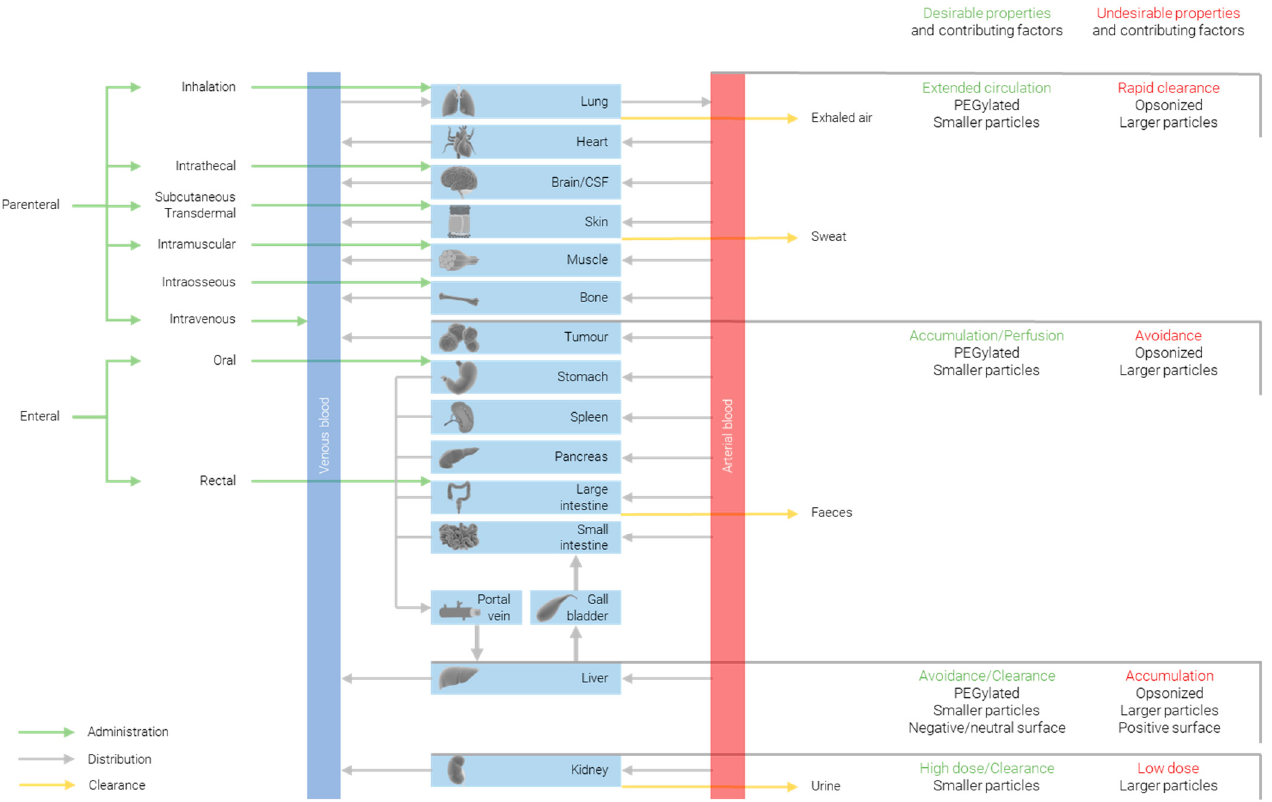
Figure 1. Approaches for modulating biodistribution of nanoparticles.